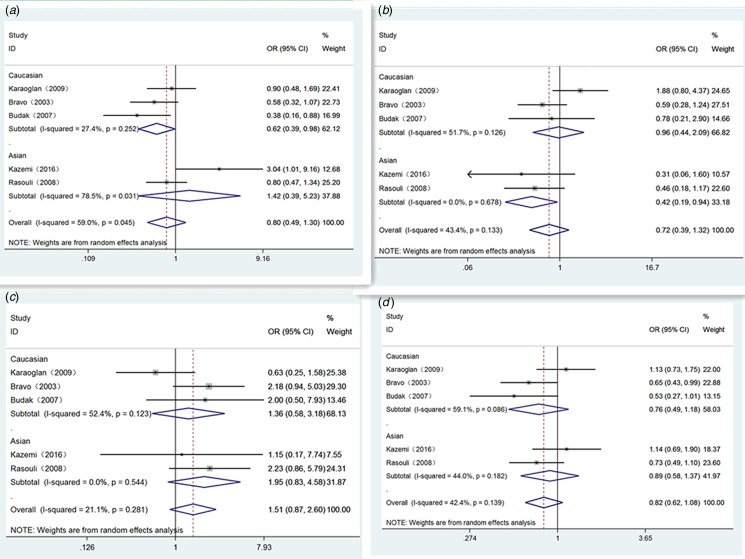
Forest plot of IL-10-819 loci polymorphism on Brucellosis risk in different genetic models. A: recessive model (TT vs. CC/TC); B: allele model (T vs. C); C: dominant model (TT/TC vs. CC) and D: homozygote model (TT vs. CC).